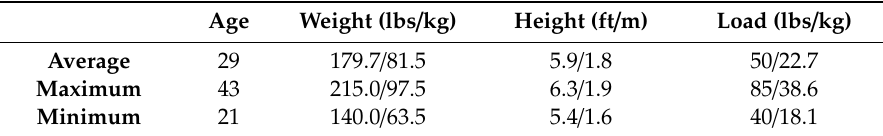
Table 1. Demographics of firefighters that collected data used in the final analysis. Age Weight (lbs / kg) Height (ft / m) Load (lbs / kg)